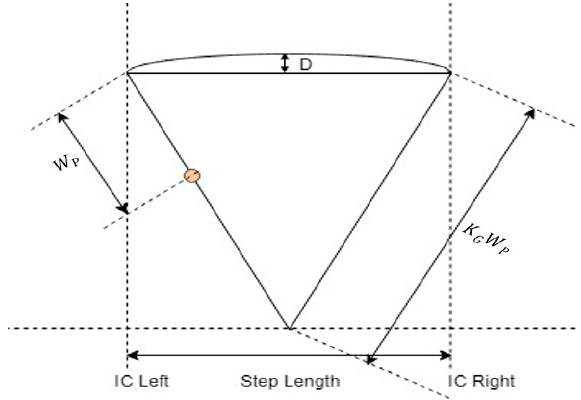
Figure 3. Extension of an inverted pendulum model for calculation of step length.